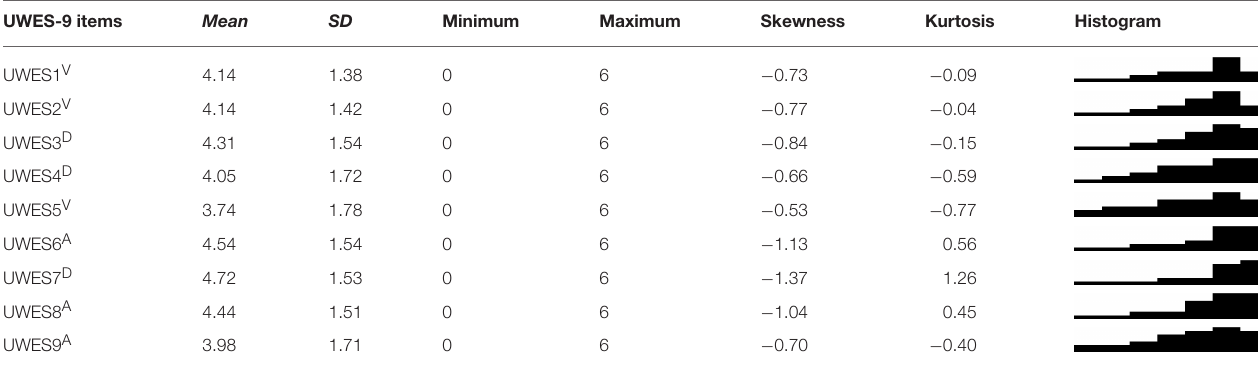
TABLE 4 | UWES’ items descriptive